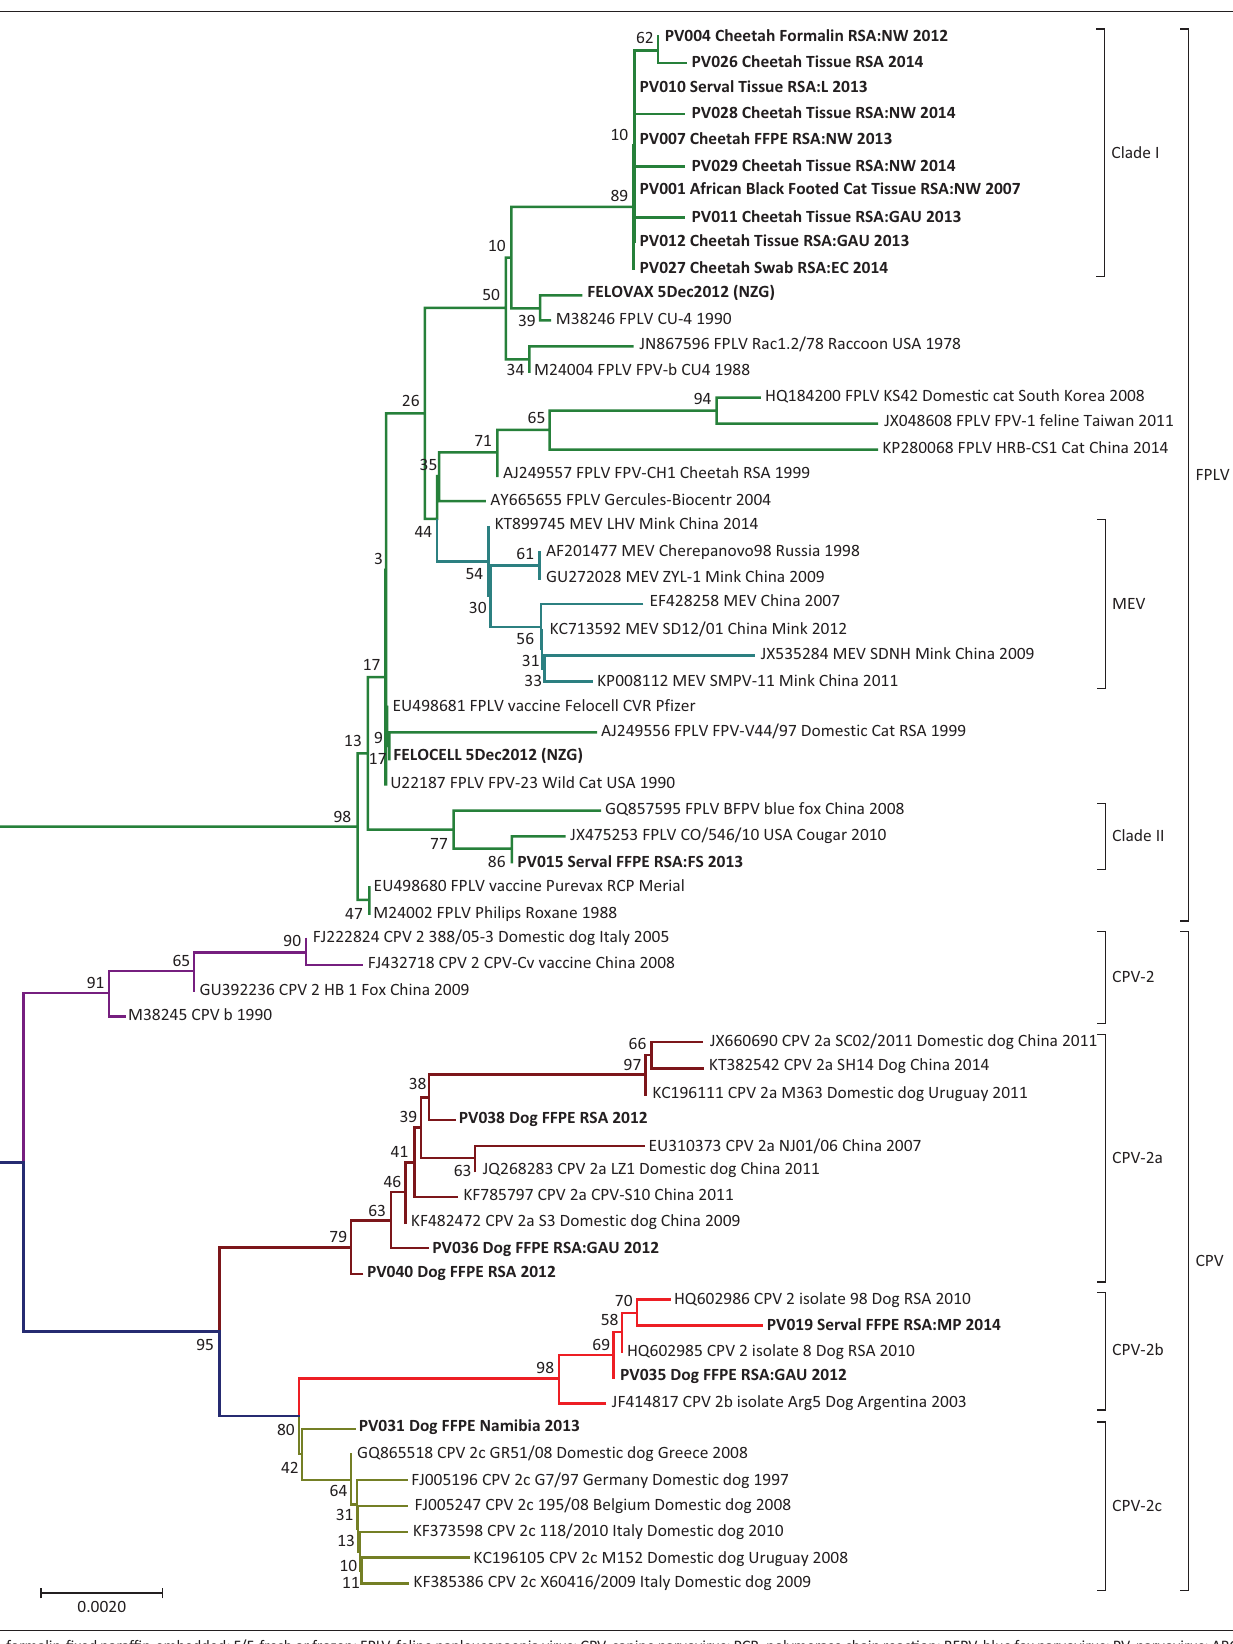
FFPE, formalin-fixed paraffin-embedded; F/F, fresh or frozen; FPLV, feline panleucopaenia virus; CPV, canine parvovirus; PCR, polymerase chain reaction; BFPV, blue fox parvovirus; PV, parvovirus; ARG, Argentina; USA, United States of America; PRT, Portugal; URY, Uruguay; ITA, Italy; BEL, Belgium; CHN, China; GRC, Greece; DEU, Germany; TWN, Taiwan; RSA, South Africa; KOR, Korea; RUS, Russia. FIGURE 1: Evolutionary relationships of detected parvoviral taxa using trimmed nucleotide sequences and the neighbour-joining method. The tree was generated using the Tamura 3-parameter model with Gamma distribution and 1000 bootstrap replicates. Cases from the NZG wildlife disease database and the study by Lane et al. (2016) are prefixed with laboratory numbers (PV), vaccine strains are prefixed with the vaccine name, and reference strains collected from GenBank are prefixed with the accession number. Rooted with CPV as the